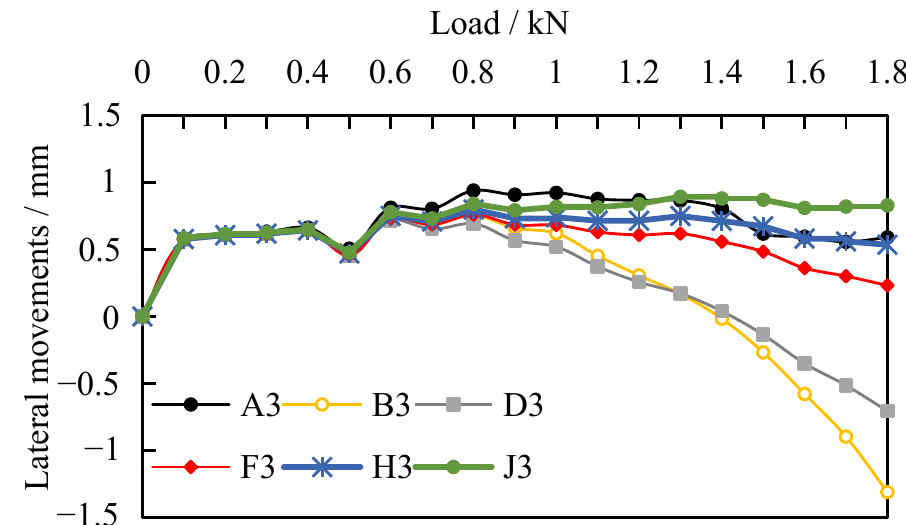
Figure 7. Horizontal displacement of each point on Axis 3 (No. 2 pile).